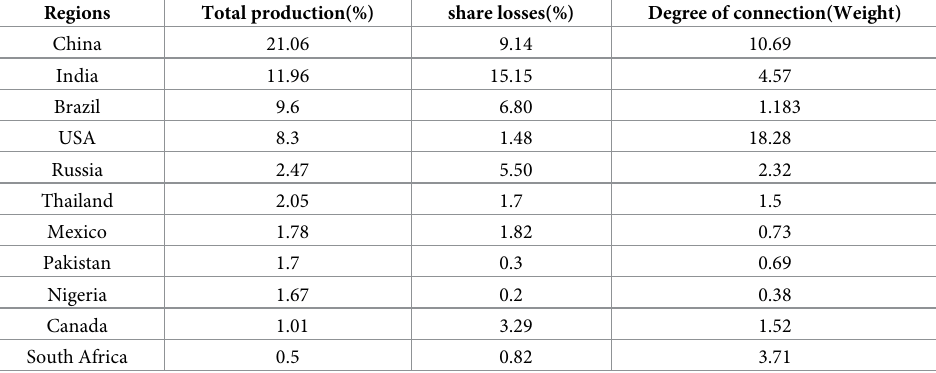
Table 1. Comparative study to assess the effects of higher degree of entanglement in global supply and trade net- work and total agricultural production on cascaded agricultural production value losses from concurrent extreme weather events.